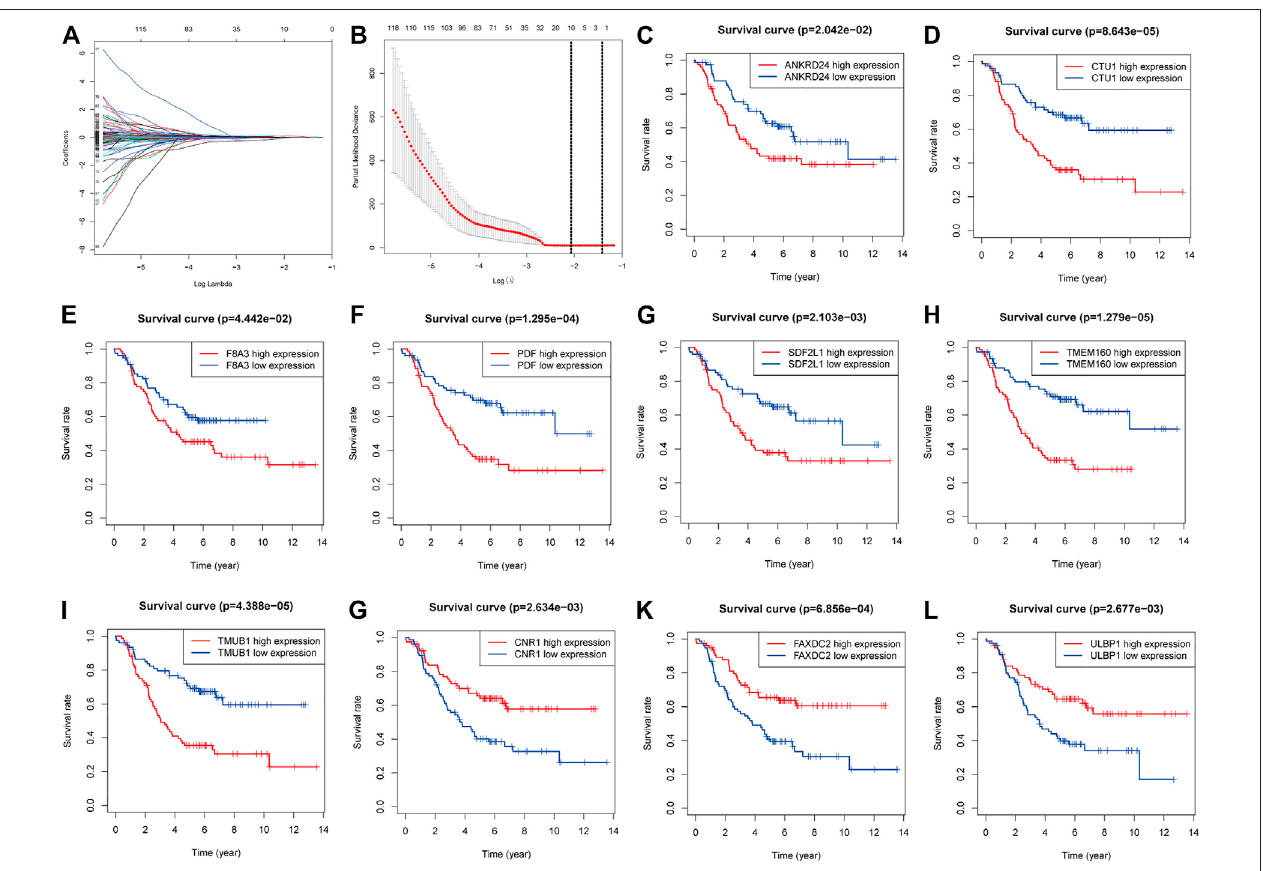
FIGURE3| ScreeninggenestoconstructingmodelofpredictingtheoverallsurvivalofNBLandKaplan – Meier(K-M)survivalanalysis. (A) .Shrinkingpathdiagramof gene entrances into the model. (B) . λ selection in the LASSO model used 10-fold cross-validation and λ (cid:1) 0.132 were selected. The K-M analysis of ANKRD24 (C) , CTU1 (D) , F8A3 (E) , PDF (F) , SDF2L1 (G) , TMEM160 (H) , TMUB1 (I) , CNR1 (G) , FAXDC2 (K) , and ULBP1 (L)